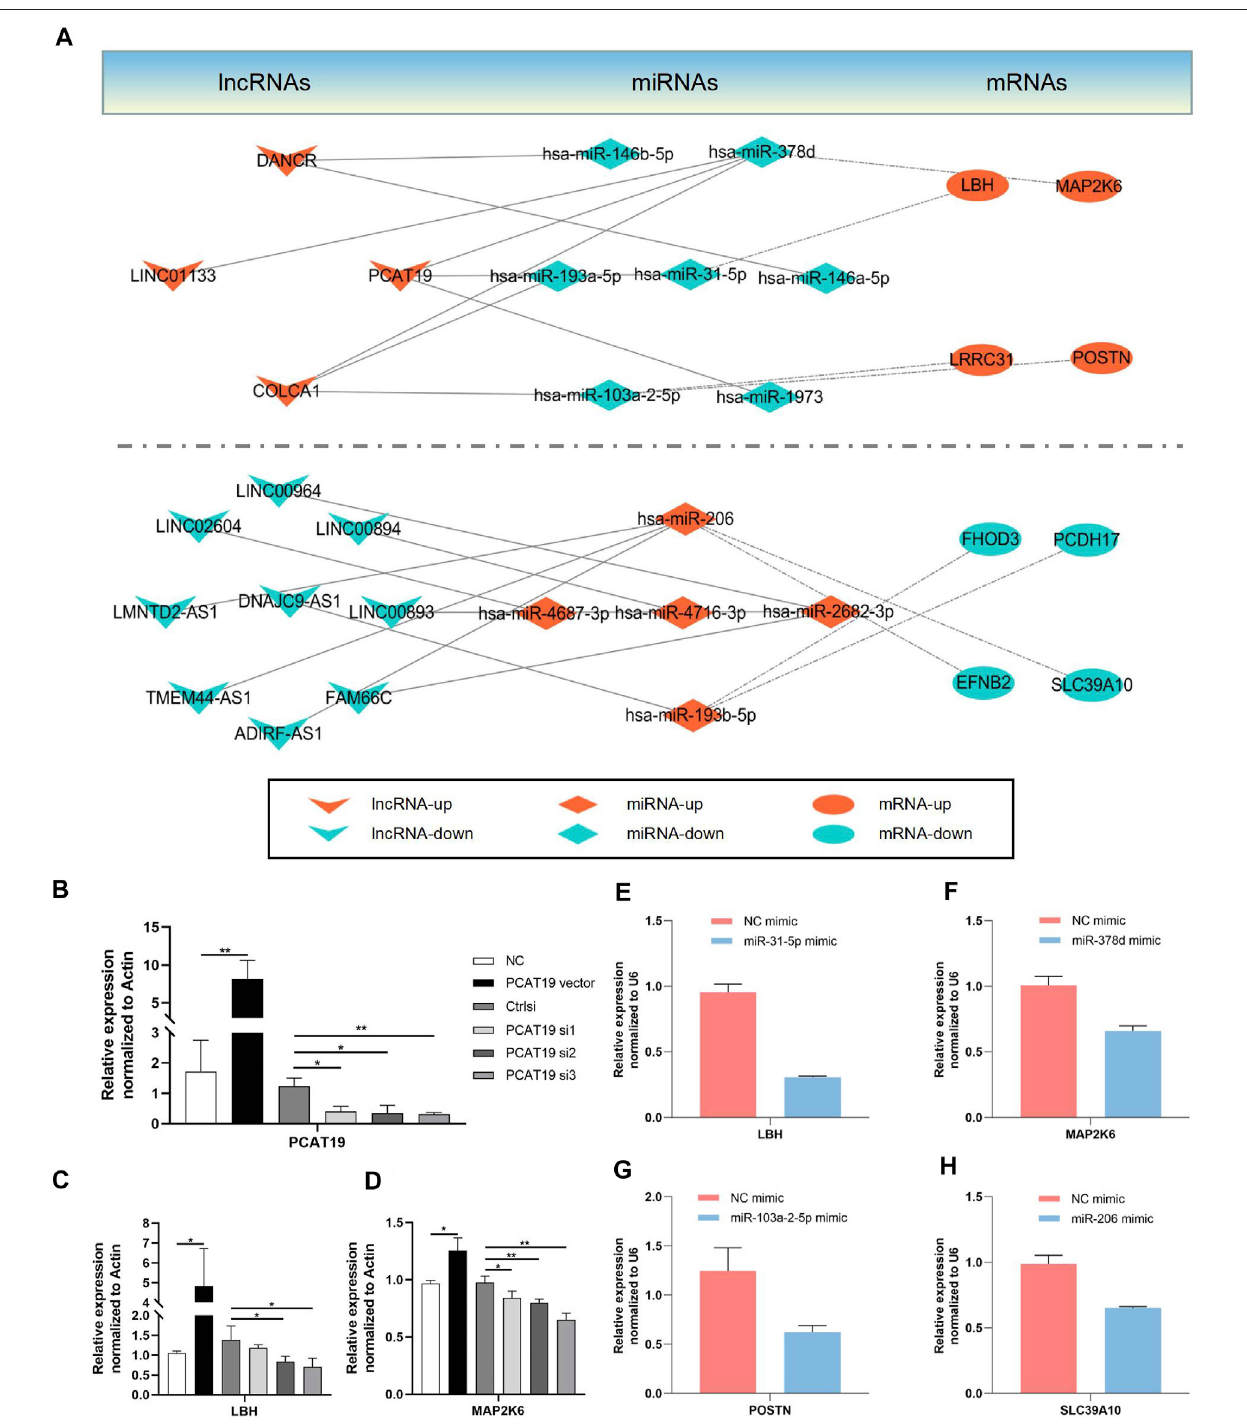
FIGURE 8 | Establishment of a ceRNA network. The lncRNA-miRNA interactions are indicated by solid lines. The mRNA-miRNA interactions are indicated by dasheddotlines.ArrowheadrepresentslncRNAs;RhombusrepresentsmiRNAs;EllipserepresentsmRNAs. (A) DElncRNA-mediatedceRNAsnetwork (B) Transfection and silencing ef fi ciency of PCAT19 were determined concomitantly by qRT-PCR. (C – H) The representative candidate genes regulated in the ceRNA network were con fi rmed by qRT-PCR. * p < 0.05; ** p < 0.01.